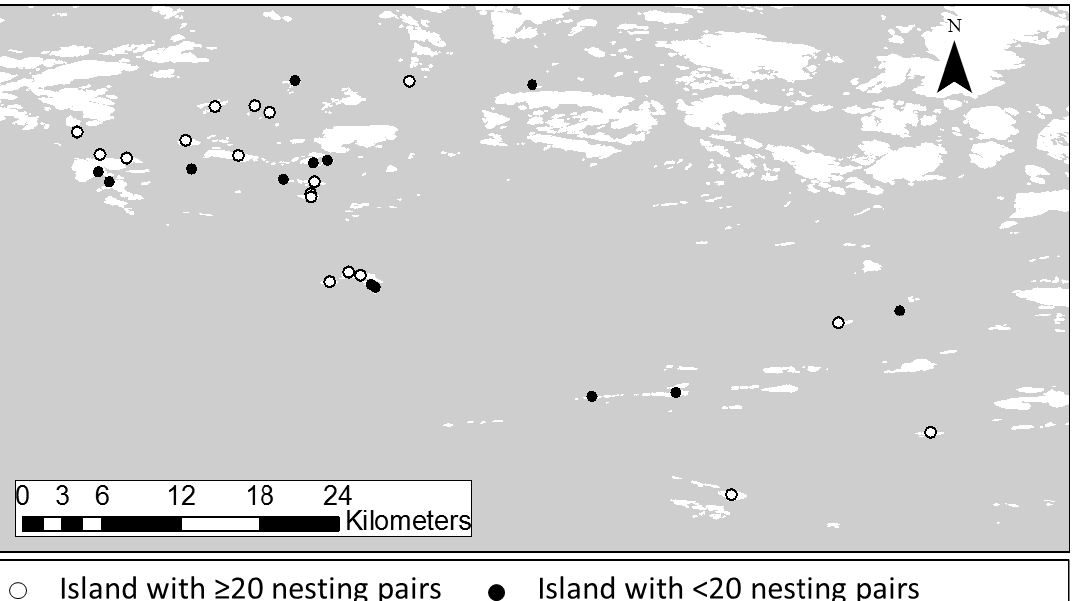
Figure A1.10. Survey zone 10: Chamberlain Islands, Southern Baffin